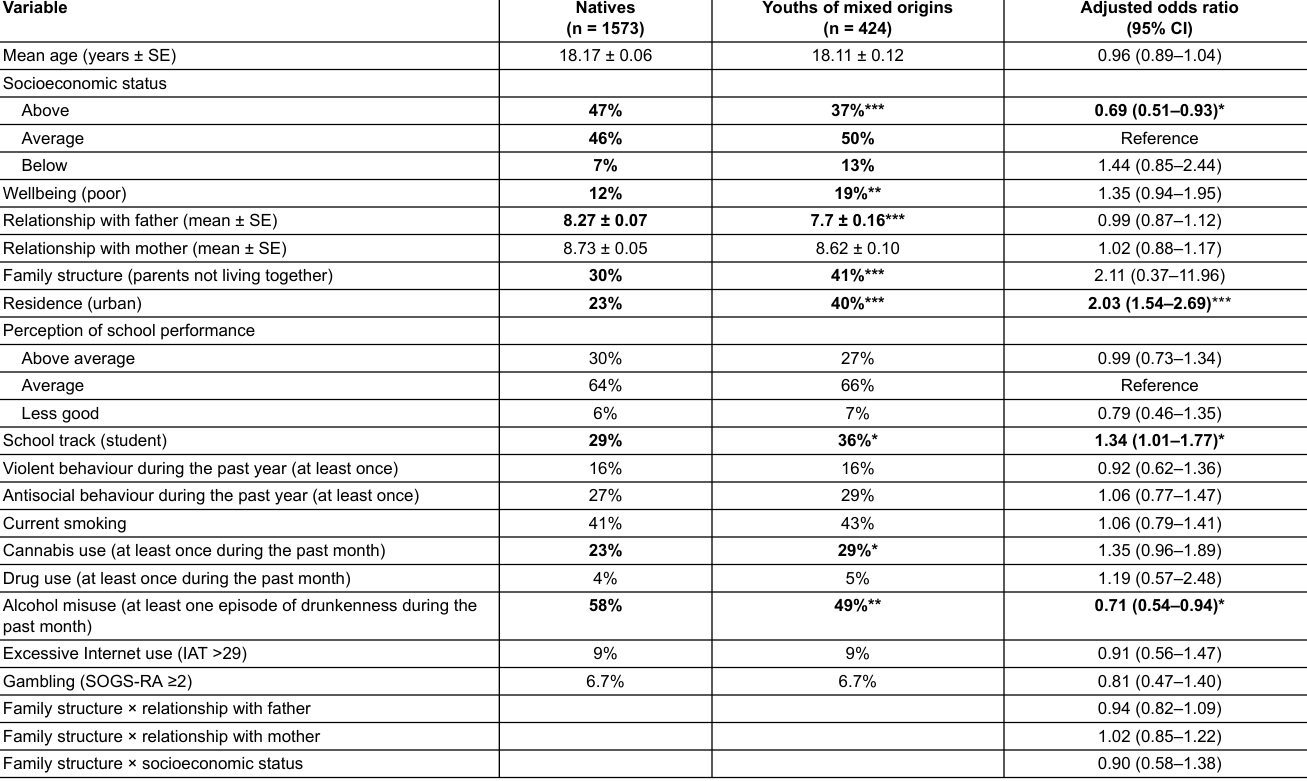
Table 3: Boys: comparison of youths of mixed origins vs natives in the age group 15–24 years in post-mandatory schools.